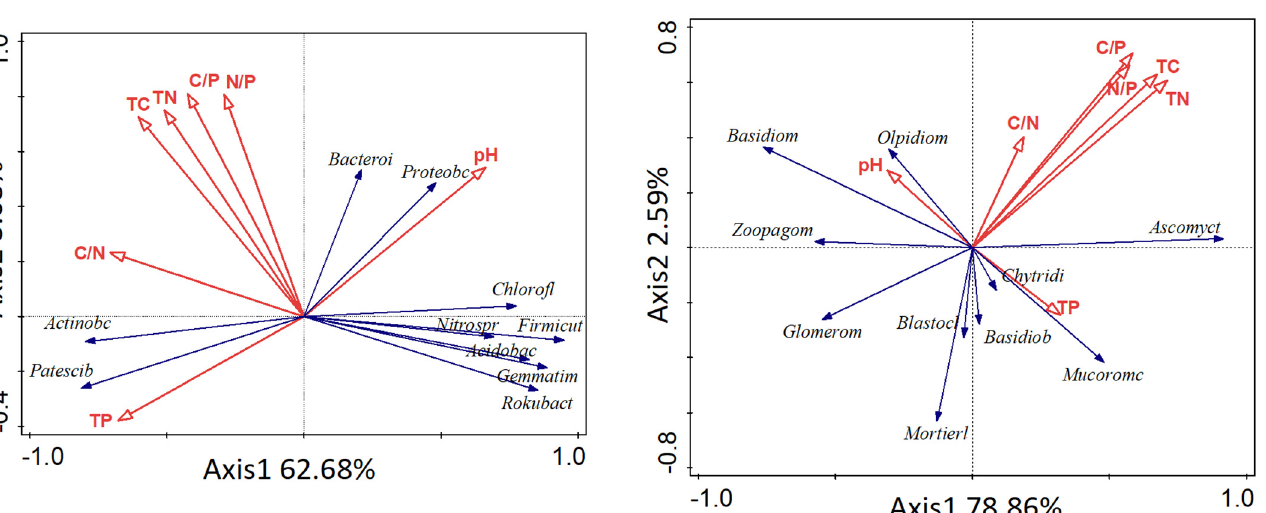
fungal RDA explained 78.86% and 2.59% of the total variance, respectively, accounting for